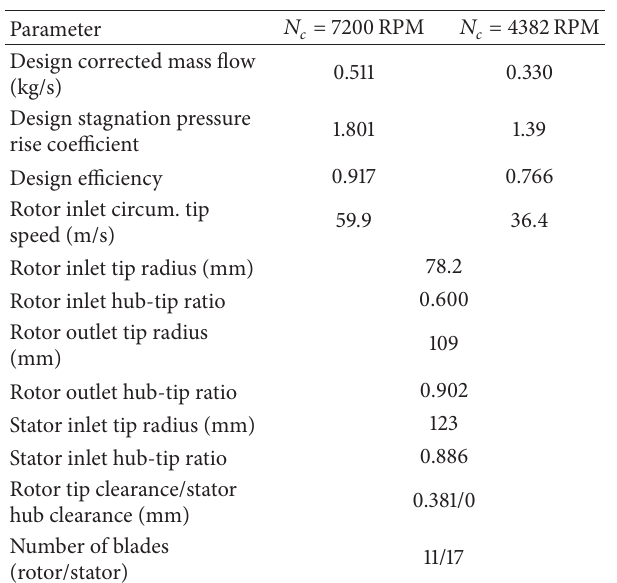
Table 2: Design parameters of the mixed flow compressor